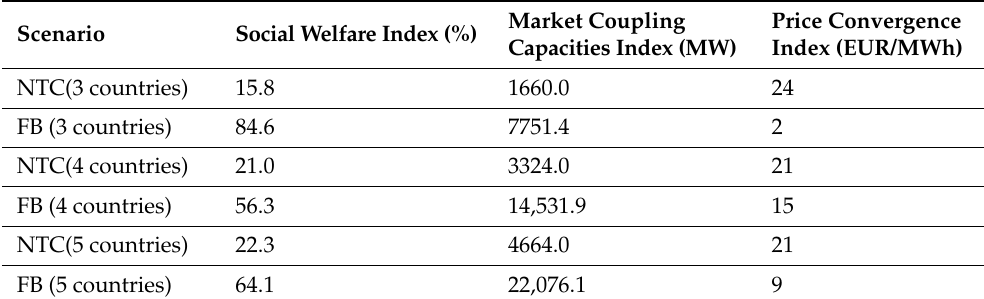
Table A5. Indexes for 26th of